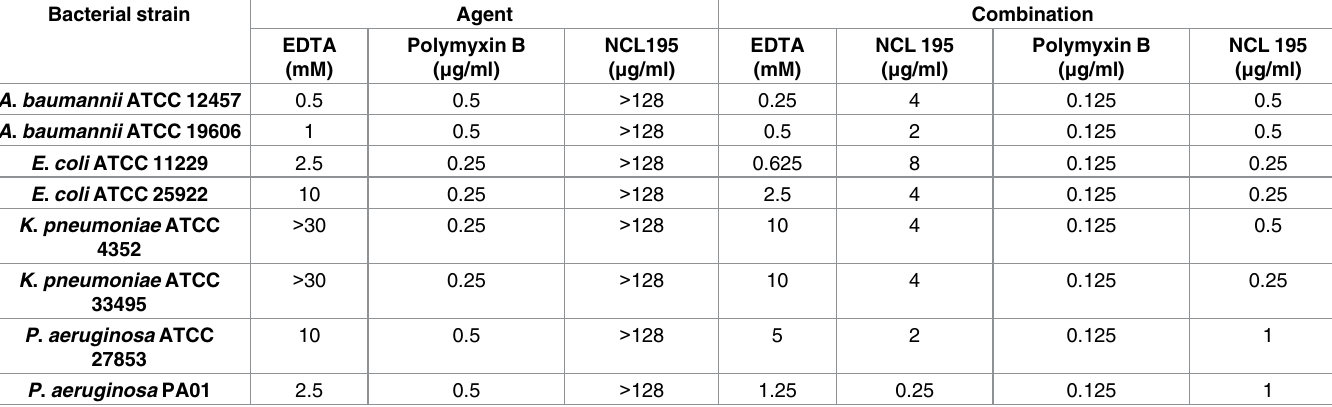
Table 2. Antimicrobial activity of NCL195against Gram-negative bacteria alone and in combination with EDTA or polymyxin B. Bacterial